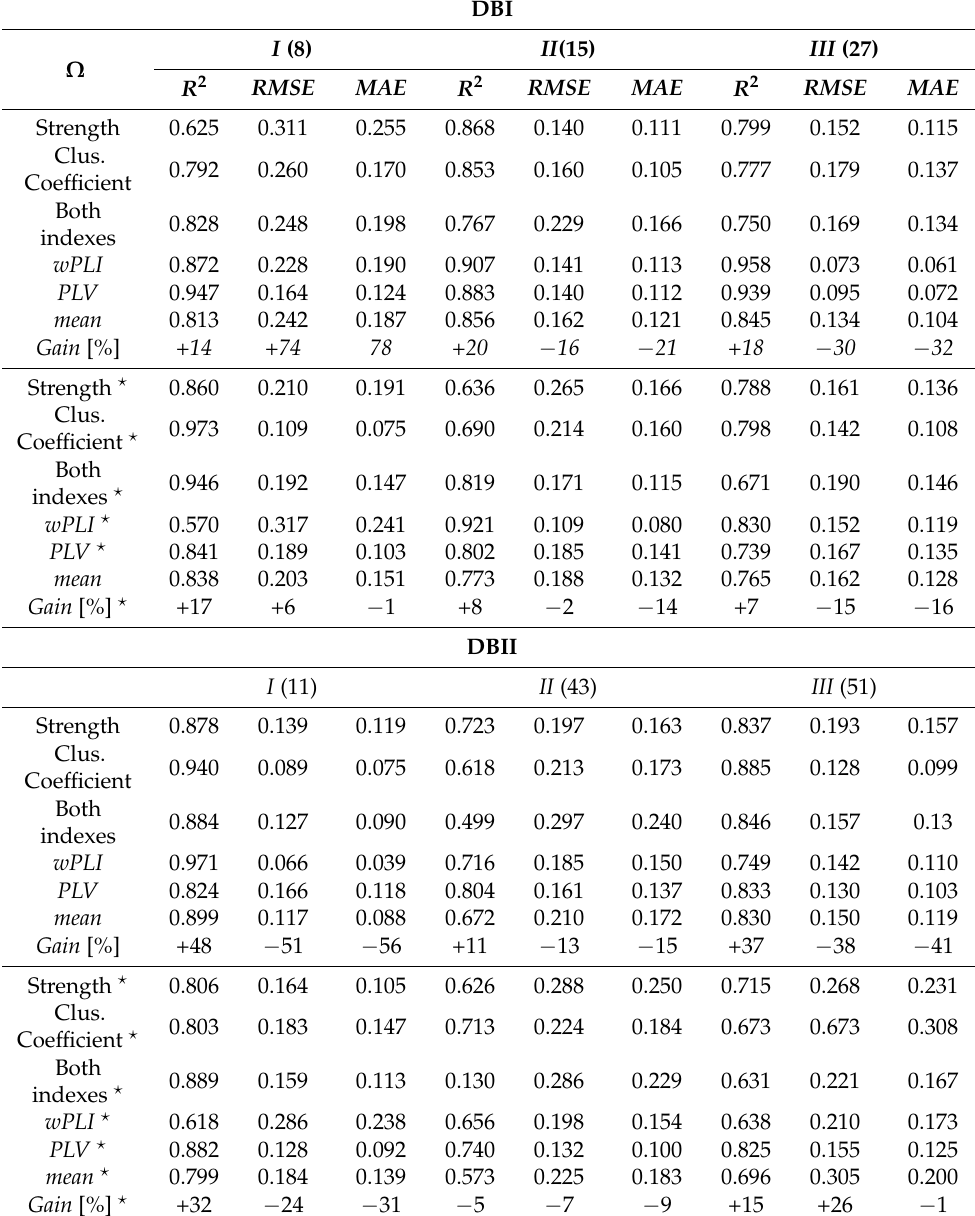
Table 5. DNR Performance of the functional connectivity (FC) predictors derived from the resting- state data achieved by each subject partition. Prediction is carried employing Monte Carlo dropout and the wide path configuration of all extracted rhythms ( θ + µ + β low